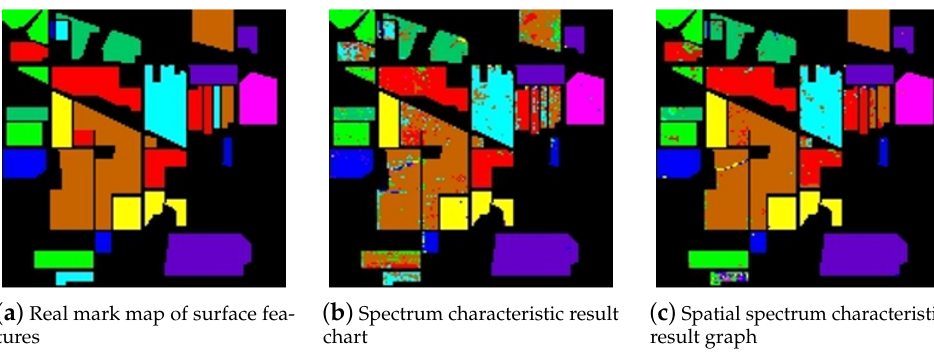
Figure 10. Classification results of Indian Pines dataset.